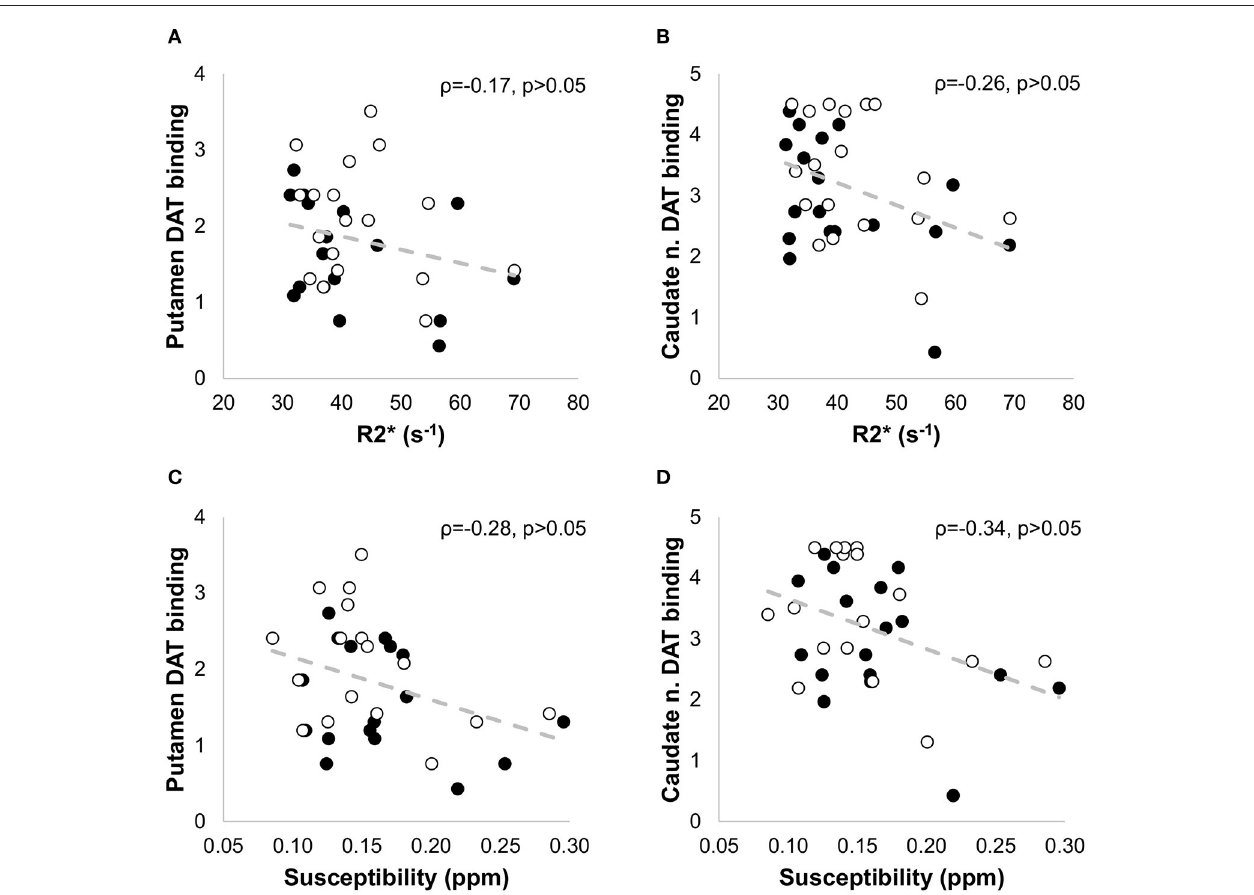
FIGURE 8 | Non parametric correlation analysis with linear regression between the SPECT measures in the putamen (A,C) and caudate nucleus (B,D) and the iron-sensitive imaging measures (R2 * and susceptibility) in patients with PD. No significant correlation was found when comparing R2 * and susceptibility values with the SPECT findings. The Spearman correlation coefficients ( ρ ) and the p -values are indicated in each figure. The filled circles correspond to the measurements in the contralateral side, and the empty circles to the measurements in the ipsilateral